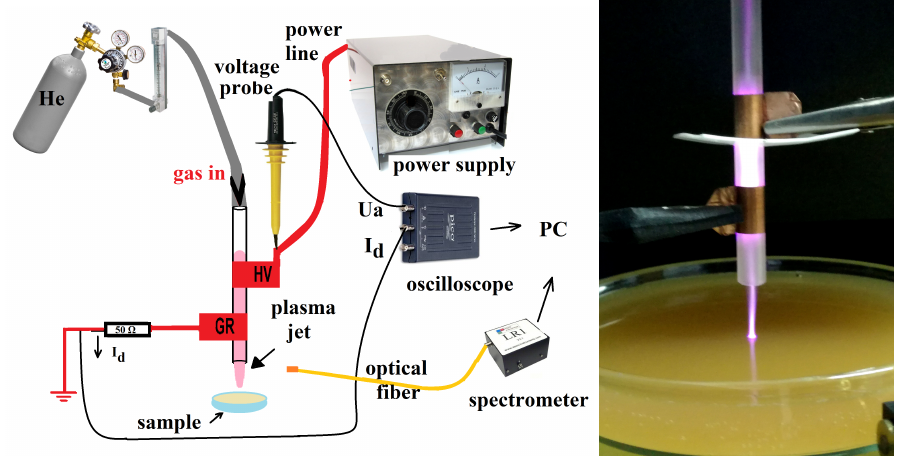
Figure 1. Plasma source set-up ( left ) and plasma-must treatment in a Petri dish ( right